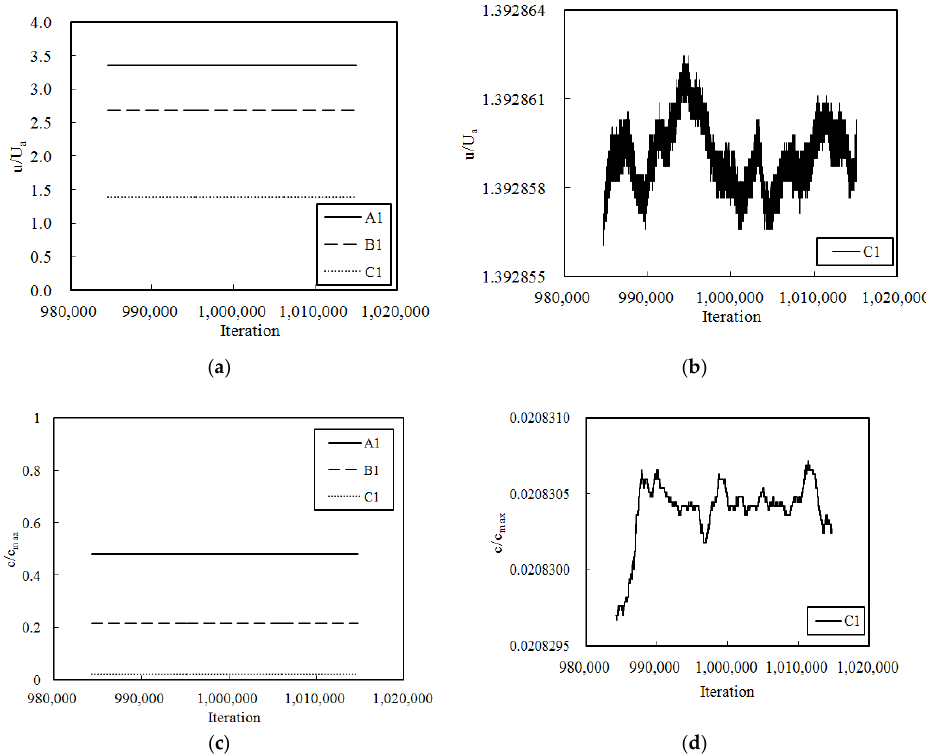
Figure 4. Iteration history on grid 1 for: ( a ) the normalized streamwise velocity u / U a , ( b ) the magnified view of the total streamwise velocity at point C1, ( c ) the normalized concentration c / c max , and ( d ) the magnified view of the total concentration at point C1.